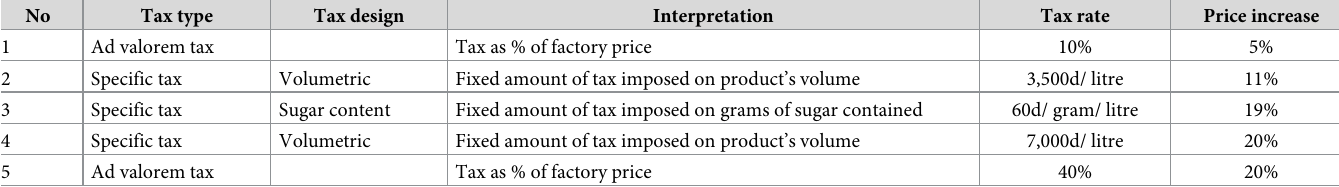
Table 2. Selected tax scenarios for